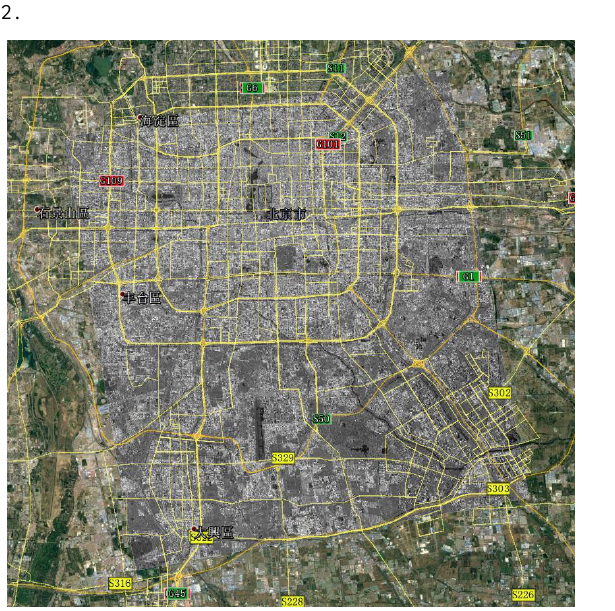
Figure 2.Coverage area of SAR image